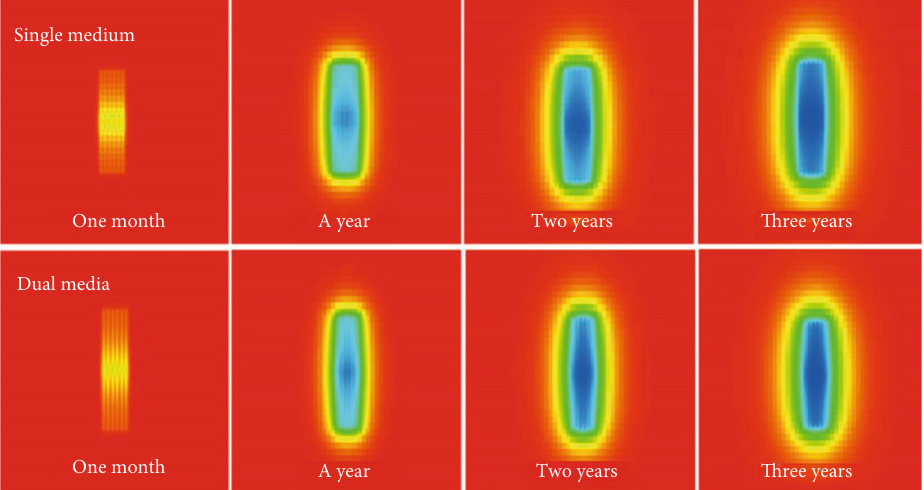
Figure 13: Pressure distribution for single medium and dual medium.